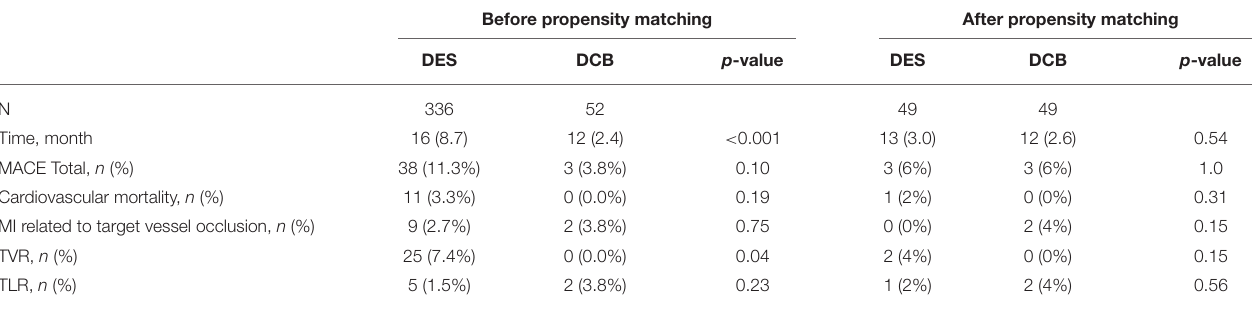
TABLE 3 | The cumulative incidence of MACE.